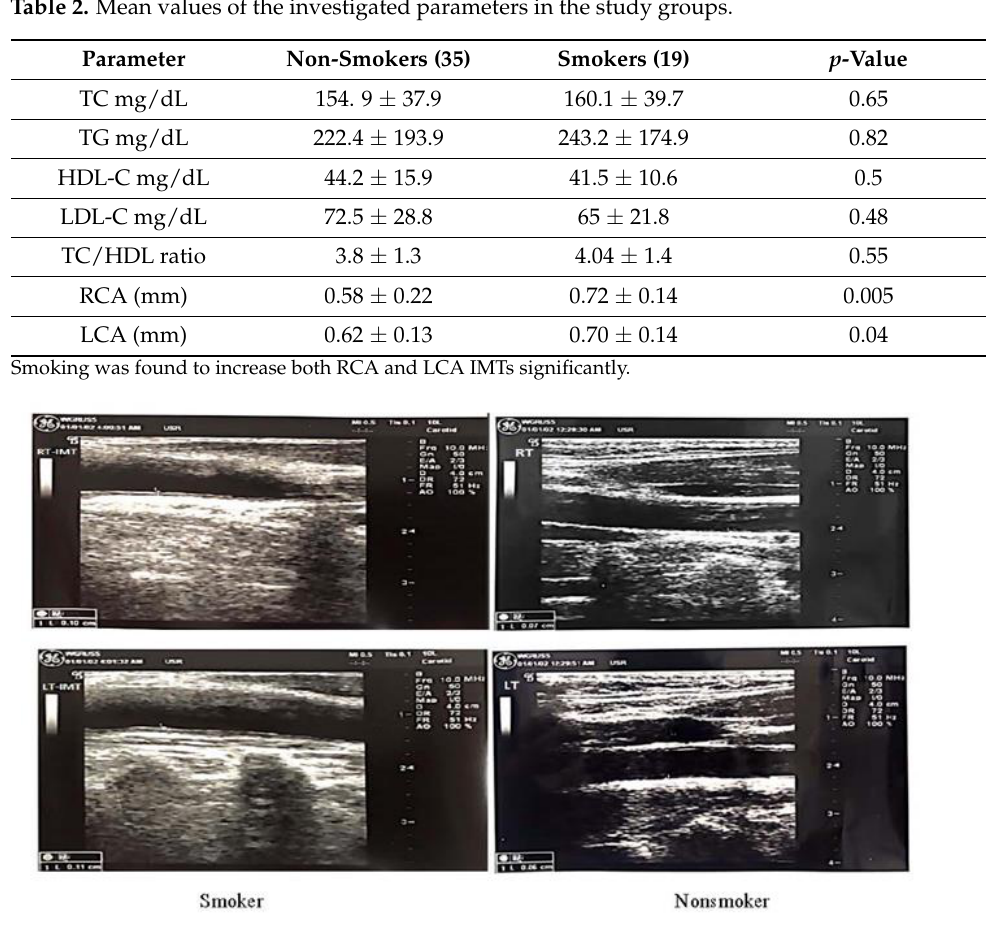
Figure 1. Increase in the thickness of the RCA and LCA. Figure 1: Increase in the thickness of the RCA and LCA. Table 2. Mean values of the investigated parameters in the study groups.